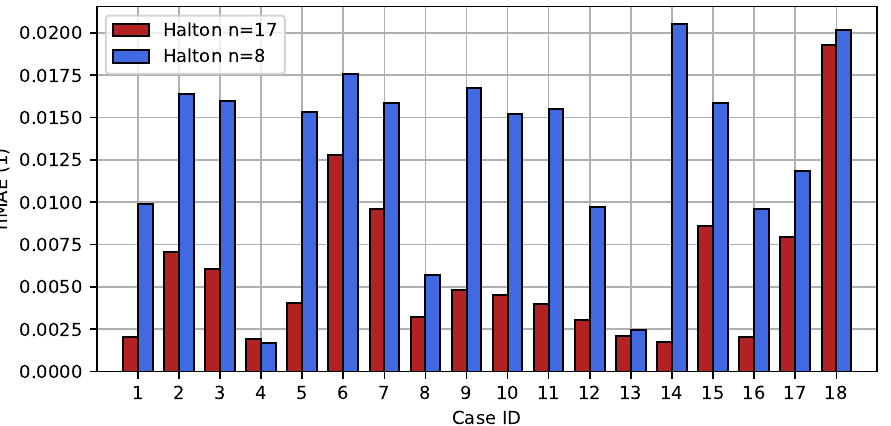
Figure 9. Normalised mean absolute error (nMAE) of the surrogate model predictions for the water mass fraction using a Halton design with 8 and 17 samples, respectively. For both designs, the TPS interpolation is used.